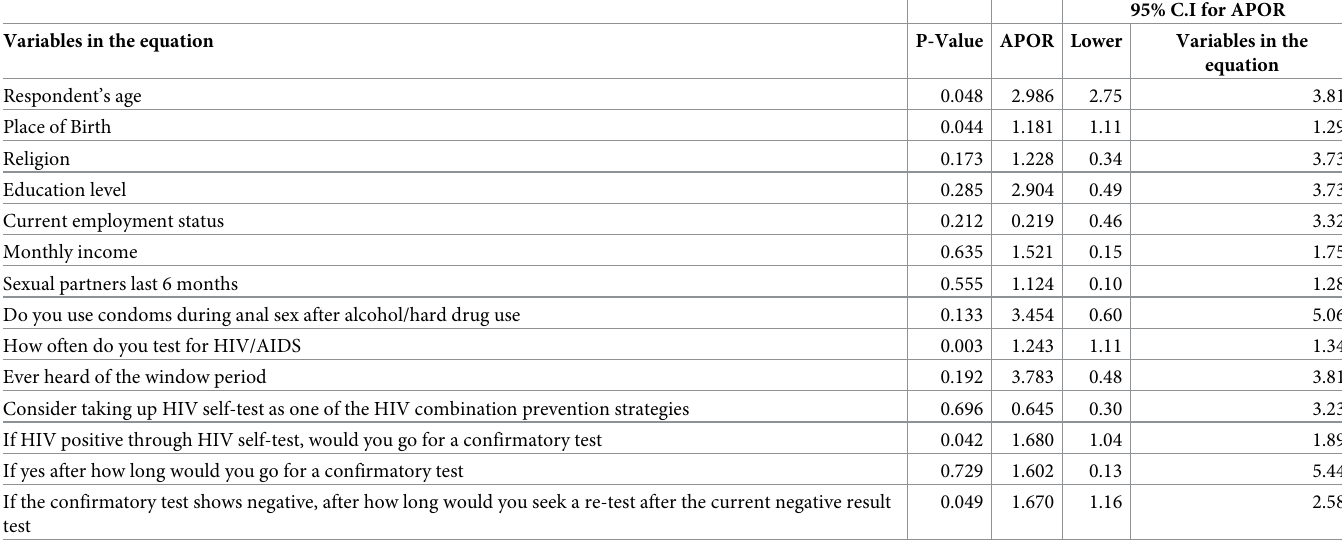
Table 4. Multivariate analysis of covariates for HIV self-testing among